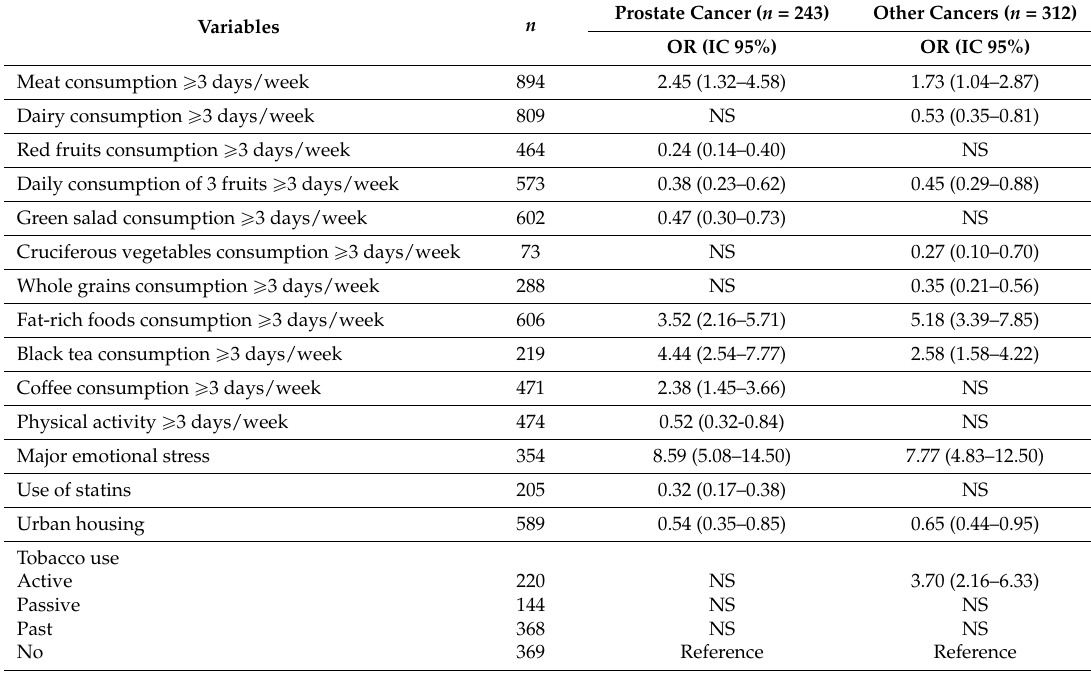
Table 4. Risk factors associated with food habits and other lifestyle aspects of study participants.